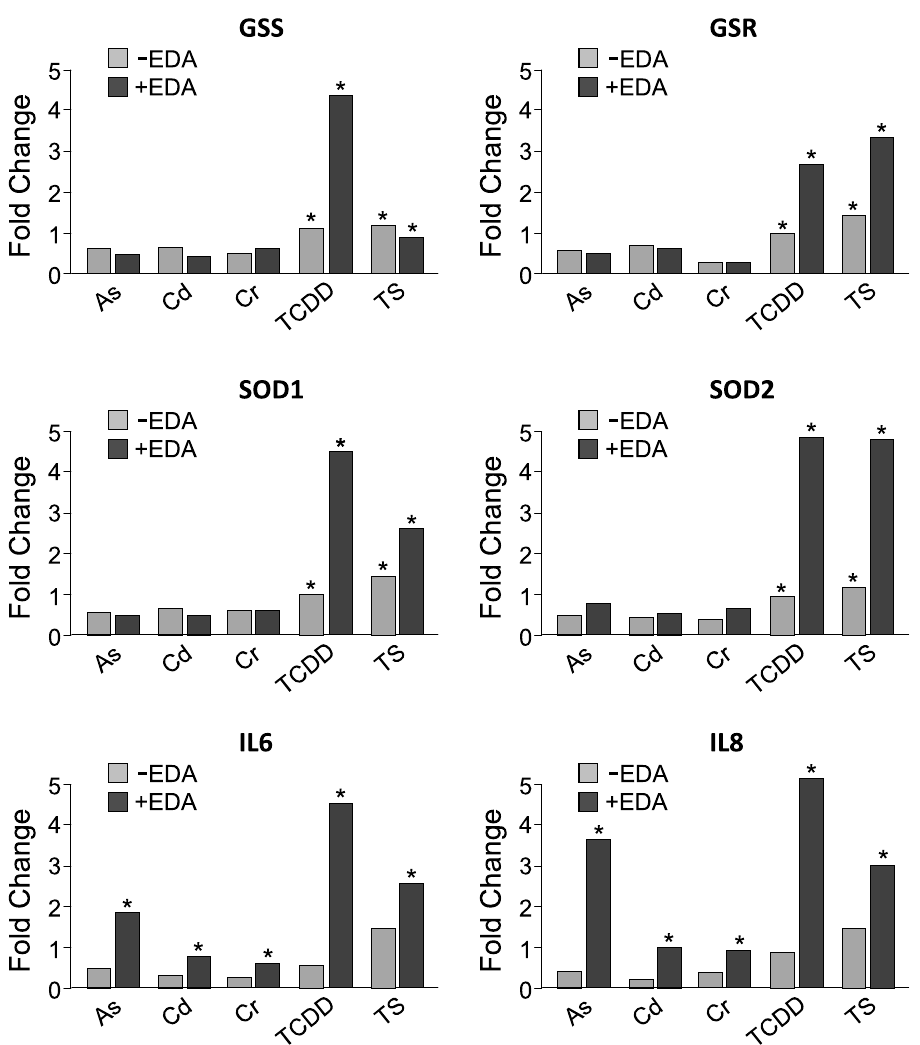
Figure 4. Deschampia antarctica aqueous extract (Edafence) promote homeostatic changes in the expression of key genes of the redox balancing and IL pro-immflamatory systems after acute exposure of Human Skin Organ Cultures to common ambient pollutants. Quantitative analysis of GSS, GSR, SOD1, SOD2, IL-6 and IL-8 gene expression by qRT-PCR in HSOC samples exposed to As(III), Cd(II), Cr(VI), 2,3,7,8-tetrachlorodibenzo-p- dioxin (TCDD) or Tobaco Smoke culture medium infusions (TS) pre-treated or not with Deschampia antarctica aqueous extracts (EDA). qRT-PCR data were analysed by a comparative C T method, using 18S rRNA expression as internal control. Gene expression fold changes were represented as the ratio between means of 2 −ΔCt values in ambient pollutant exposed samples with respect to control samples in triplicates from two independent experiments (*, significant p ≤